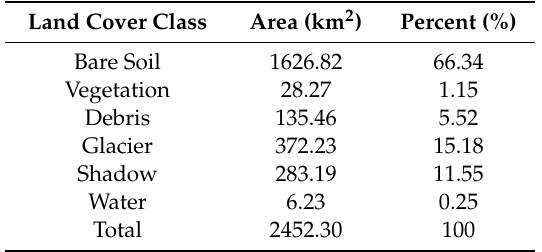
Table 6. The area for each land cover class obtained by the Random Forest classifier.